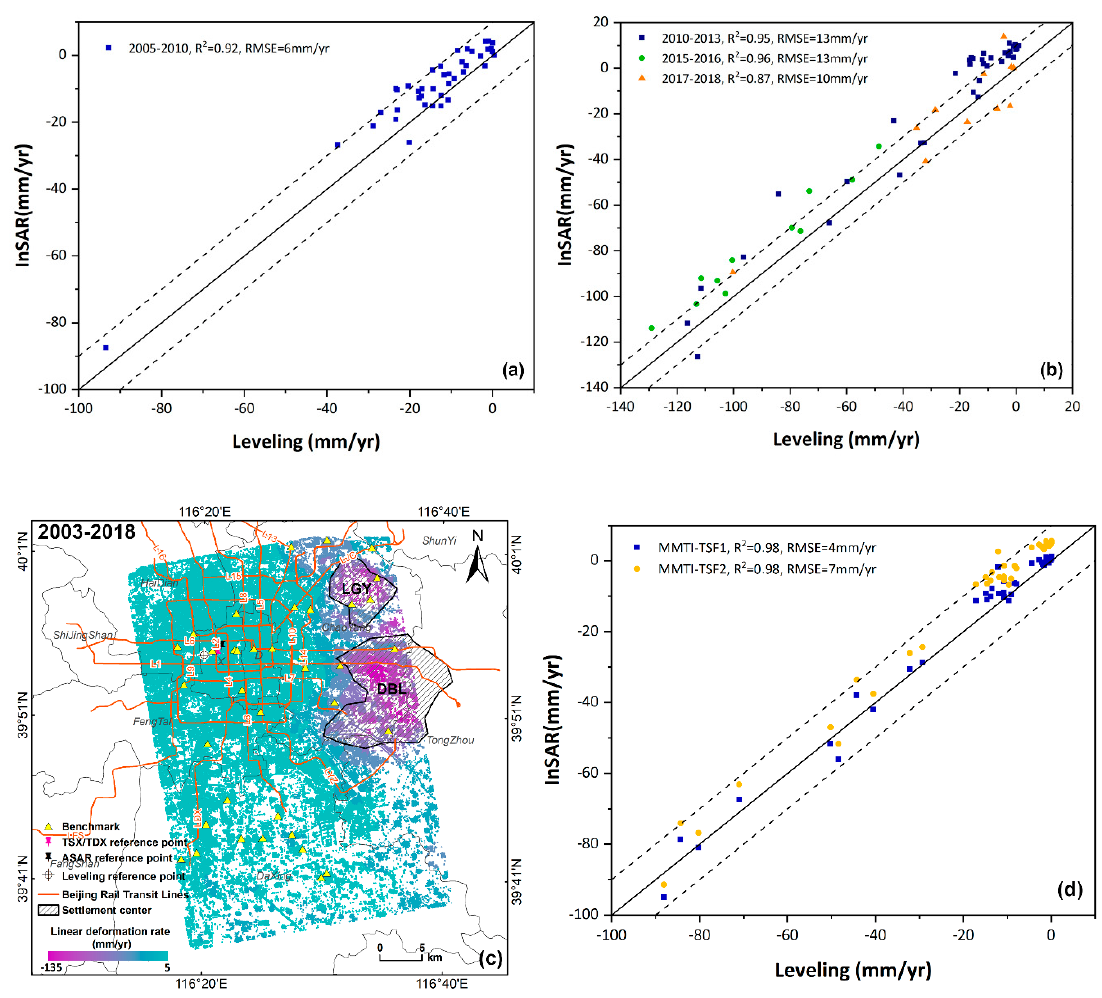
Figure 8. Comparison of InSAR analysis and leveling of vertical displacement rate before and after fusion. ( a , b ) show the comparison of linear deformation rates of InSAR analysis and leveling of TSX / TDX and ASAR before fusion, respectively. The position of the leveling point is shown in Figure 4. ( a – c ) show the calculation results of the linear subsidence rate (2003–2018) calculated after the fusion. ( d ) shows the accuracy verification result of the two fusion methods.